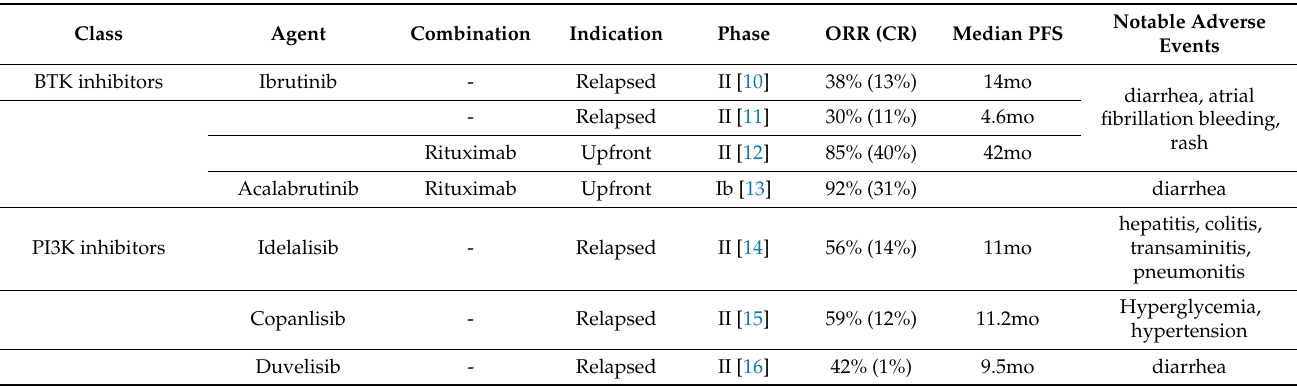
Figure 1. Novel targeted therapeutic classes in follicular lymphoma (FL). Schematic diagram of novel agents grouped according to their mechanism of action. Abbreviations: BCR, B-cell receptor; PI3K, phosphatidylinositol-3-kinase; BTK, Bruton tyrosine kinase; SYK, spleen tyrosine kinase; mAb, monoclonal antibody; PD-1, programmed death-1; CAR, chimeric antigen receptor; NK, natural killer. Table 1. Summary of targeted treatments in follicular lymphoma. Abbreviations: ORR, overall response rate; CR, complete response; PFS, progression-free survival; -, no additional agent; BTK, Bruton tyrosine kinase; PI3K, phosphatidylinositol-3- kinase; SYK, spleen tyrosine kinase; BR, bendamustine-rituximab; CAR, chimeric antigen receptor; CRS, cytokine-release syndrome; ICANS, immune effector cell-associated neurotoxicity